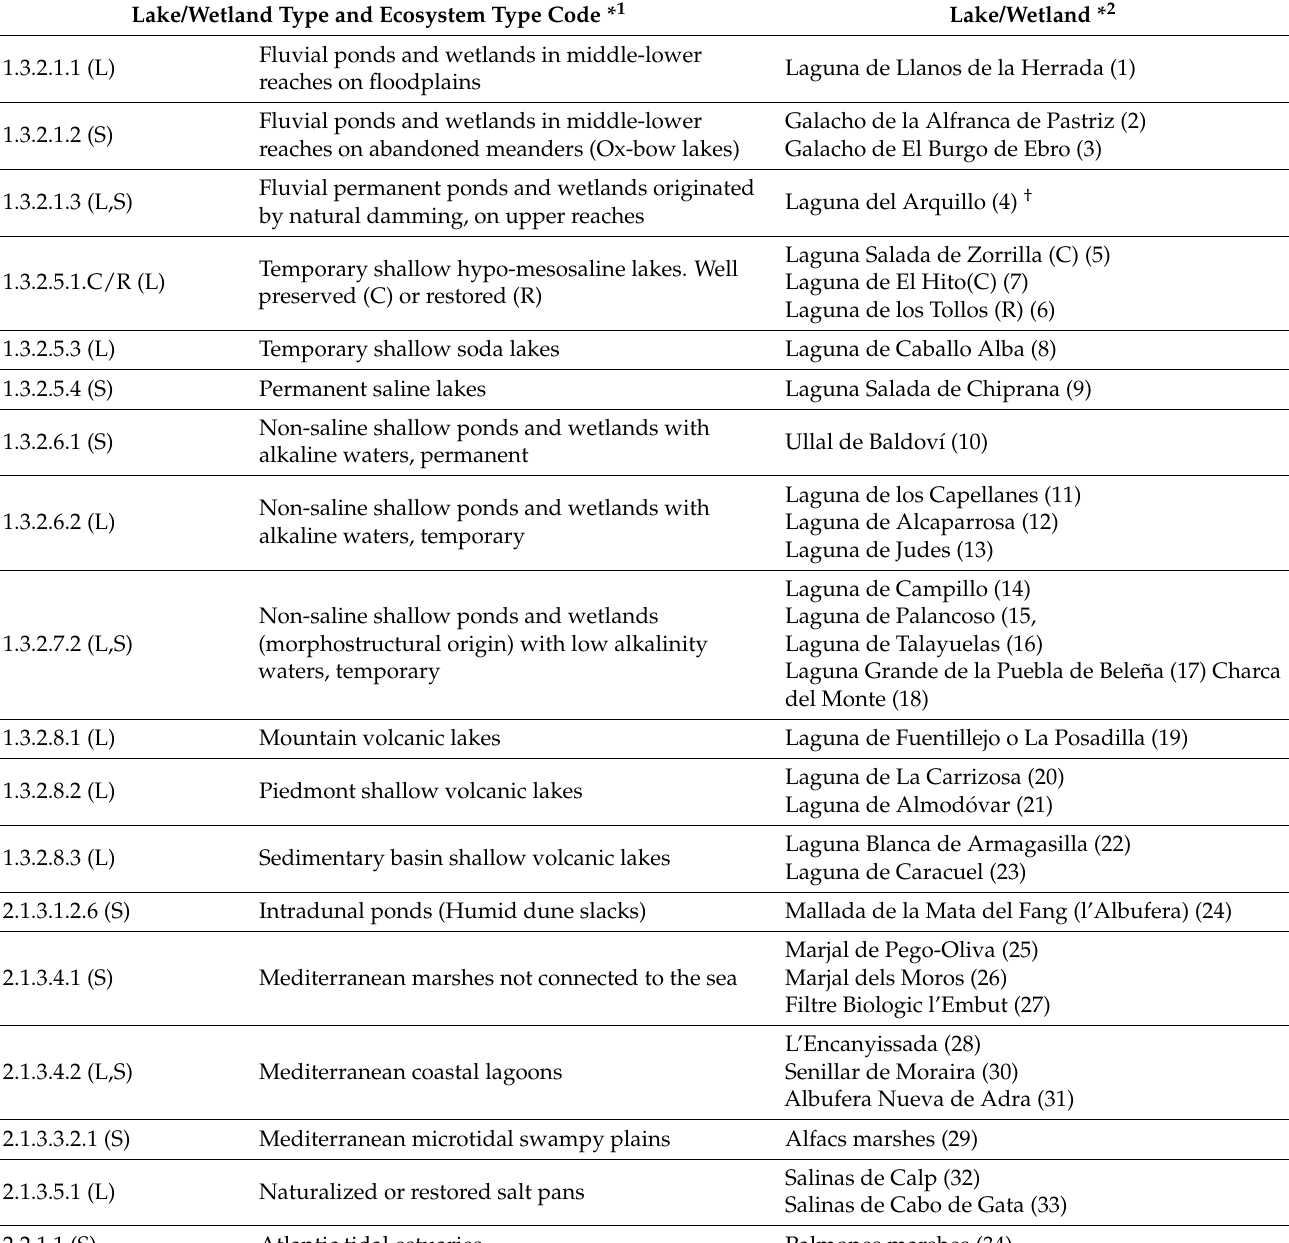
Table 1. Lakes and wetlands studied, including the ecological type as classified following Camacho et al. [36]. Lake/Wetland Type and Ecosystem Type Code *